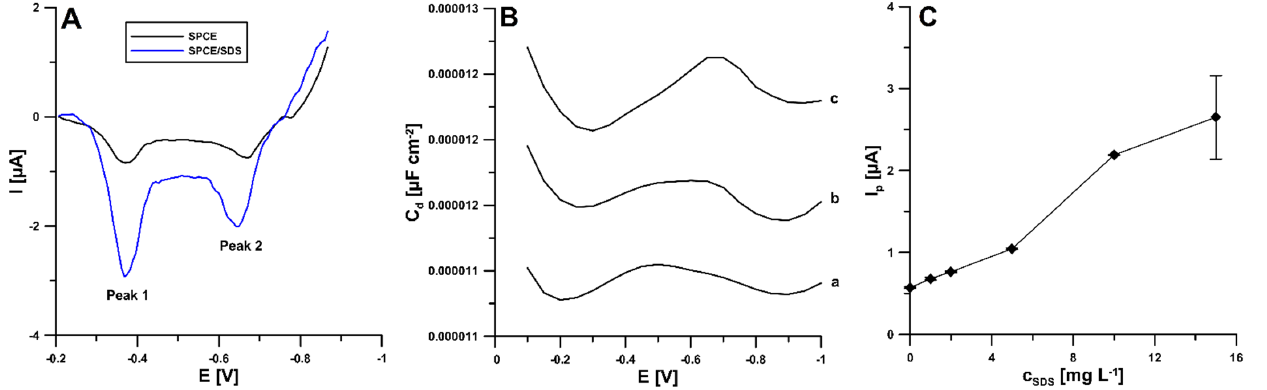
Figure 3. ( A ) Voltammograms of 50 nM NDIT obtained at the SPCE and SPCE/SDS (in the pres- ence of 10 mg/L SDS). ( B ) The differential capacity–potential curves of the double-layer interface SPCE/supporting electrolyte in the presence of 0 (a), 10 (b), and 20 (c) mg L − 1 SDS. ( C ) The relation- ship between the 50 nM NDIT peak current and SDS concentration from 0 to 15